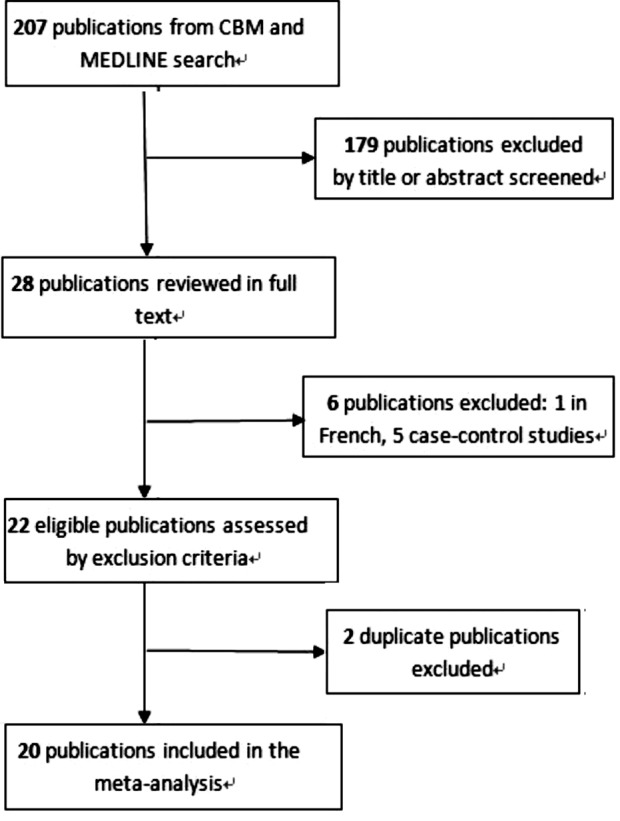
Flow diagram of selection of relevant publications.